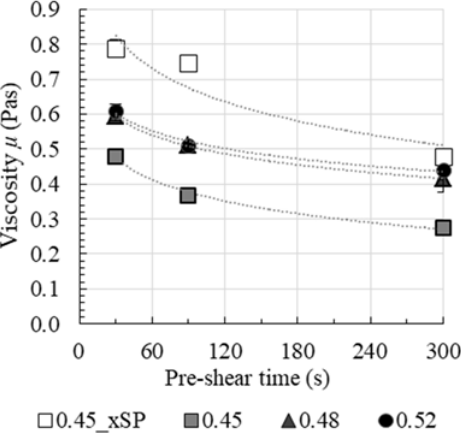
Figure 8. E ff ect of pre-shear time on Figure 8. Effect of pre ‐ shear time on viscosity.